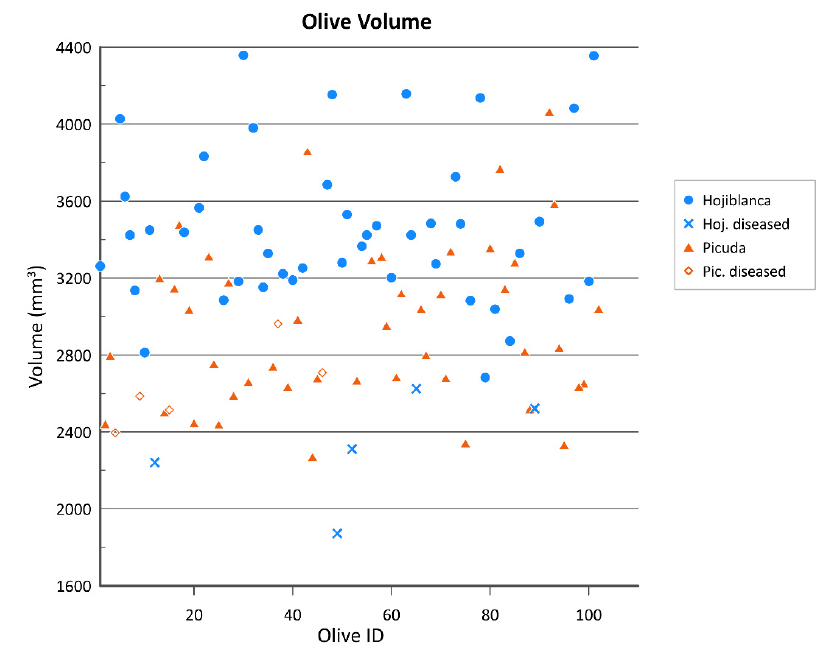
Table 5. Data distribution.